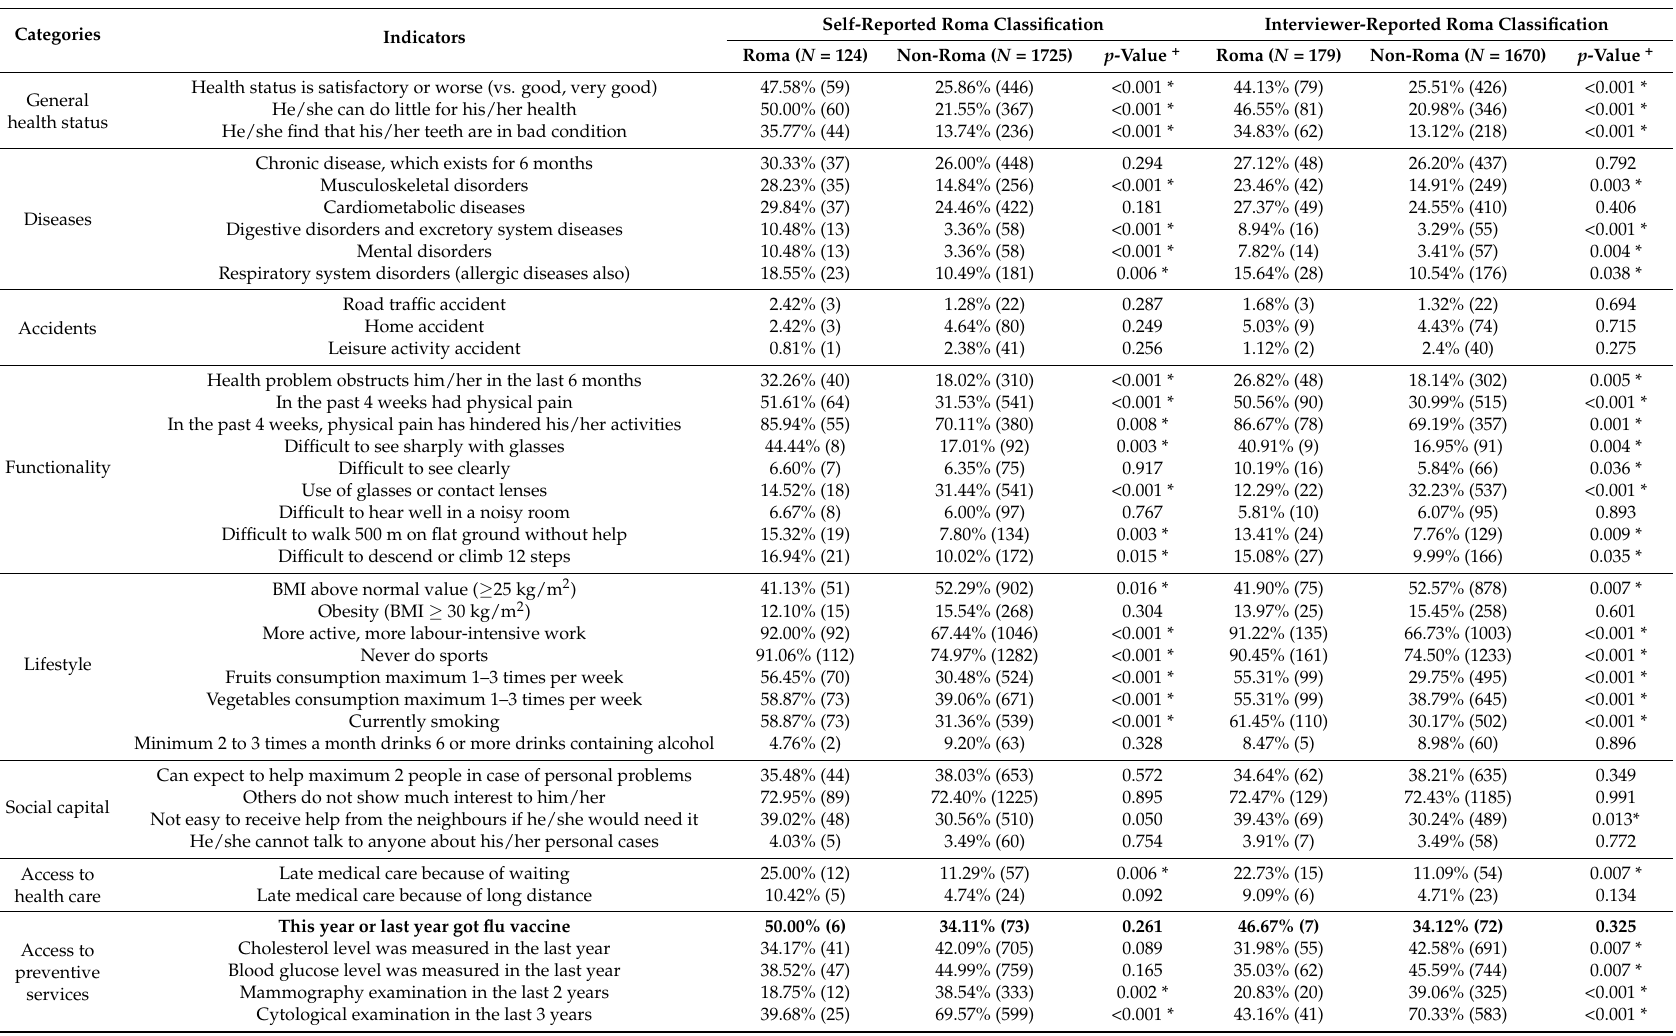
Table 3. Unadjusted descriptive health status indicators for the Roma and non-Roma